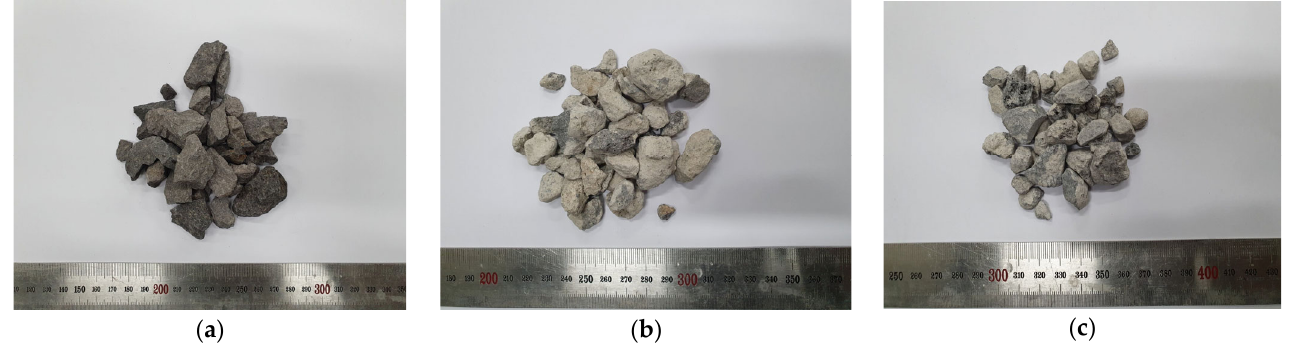
Figure 2. Manufacturing process of the recycled aggregate. ( a ) Type A; ( b ) Type B.